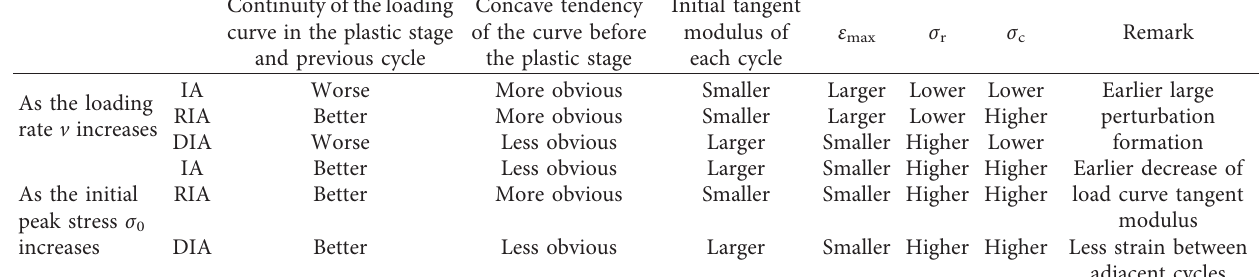
Table 5: Evolution laws of the mechanical properties under different loading rates and initial peak stresses.